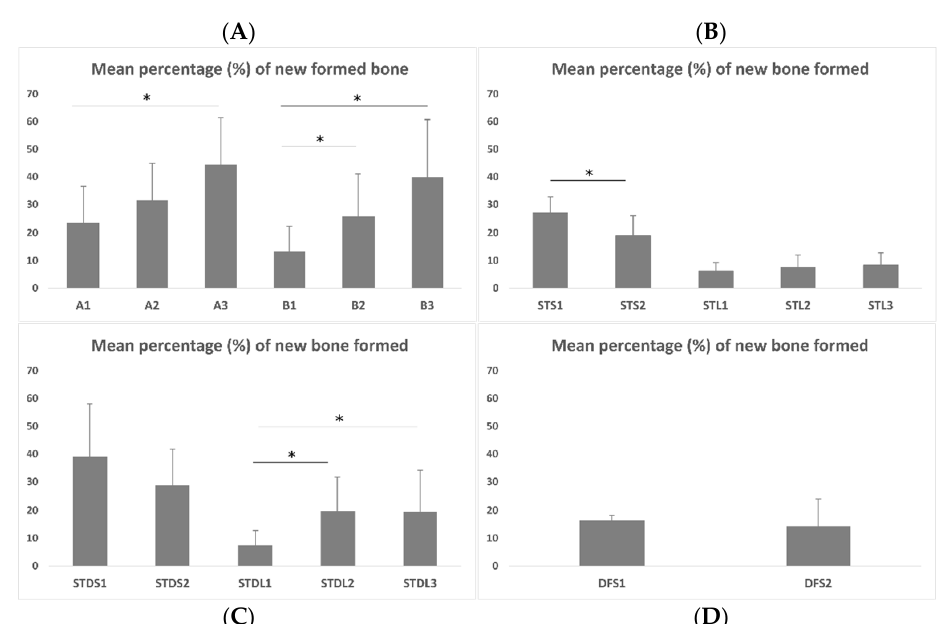
Figure 3. The average percentage (%) of newly formed bone in different groups. ( A ) Control vs. application of collagen membrane; ( B ) Systemic vs. local administration of simvastatin dissolved in water; ( C ) Systemic vs. local administration of simvastatin dissolved in DMSO; ( D ) Systemic (intramuscular) administration of diclofenac. * means statistically significant difference between the subgroups of each group (at different experimental time span).